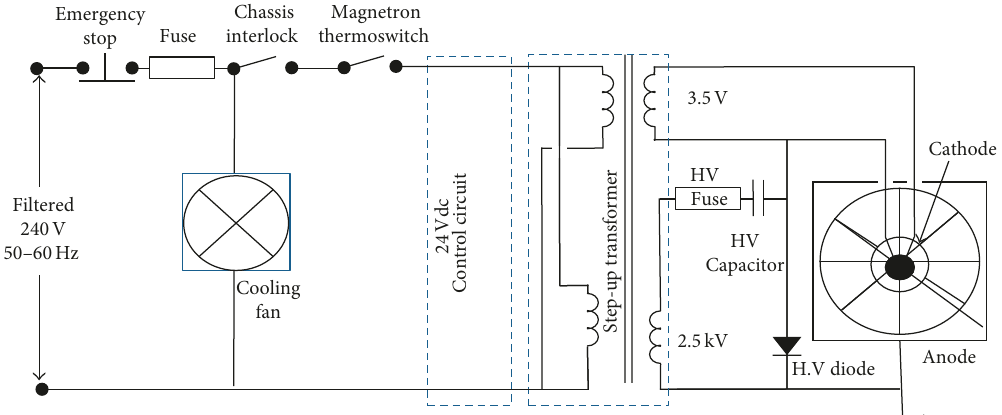
Figure 7: Cavity magnetron capacitor-controlled dive circuit. The 24V DC control circuit represented by the dashed box is discussed in Section